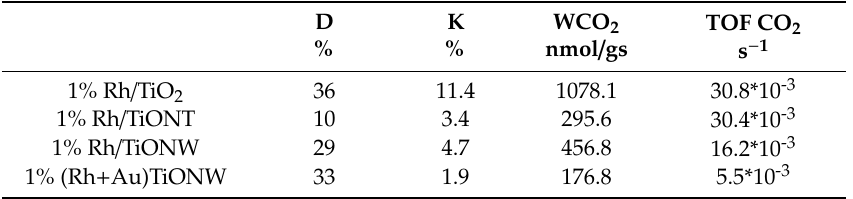
Table 3. Activity data obtained in the CO + H 2 O reaction over di ff erent catalysts in the quasi steady-state